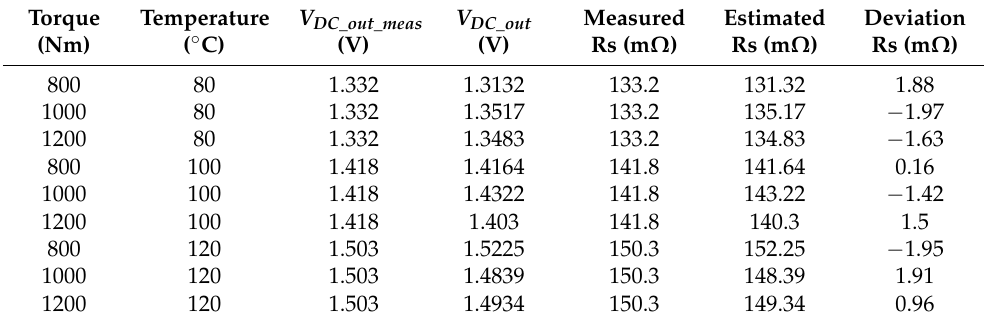
The Figure 8 the stator current during the injection. Figure 9 shows the estimated